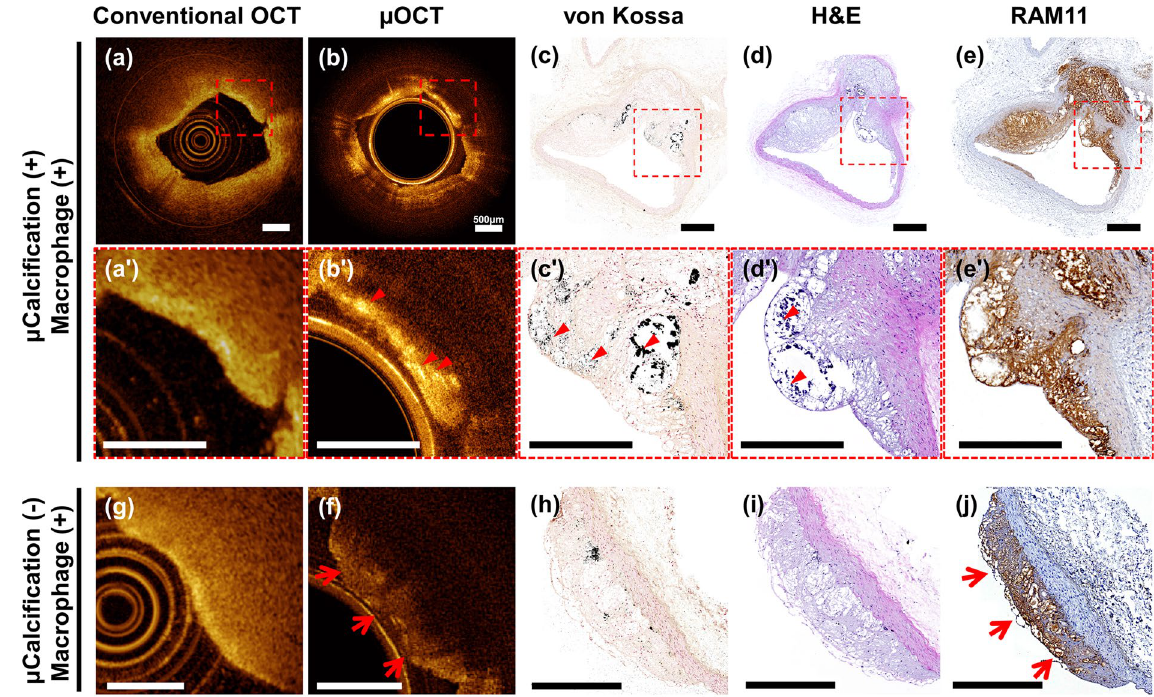
Figure 8. ( a – e’ ) Comparison among conventional OCT, μ OCT and histologic evaluation of a high-risk plaque with microcalcification; ( a,a’ ) Conventional OCT images showing ill-defined signal-poor region; ( b,b’ ) μ OCT images showing multiple bright spots (red arrowheads); The red arrowheads indicate the corresponding microcalcification in μ OCT ( b’ ), von Kossa ( c’ ) and H&E ( d’ ), and RAM11 ( e’ ) images; ( g–j ) Imaging findings from a plaque without surface microcalcification. Scale bars, 500 μ